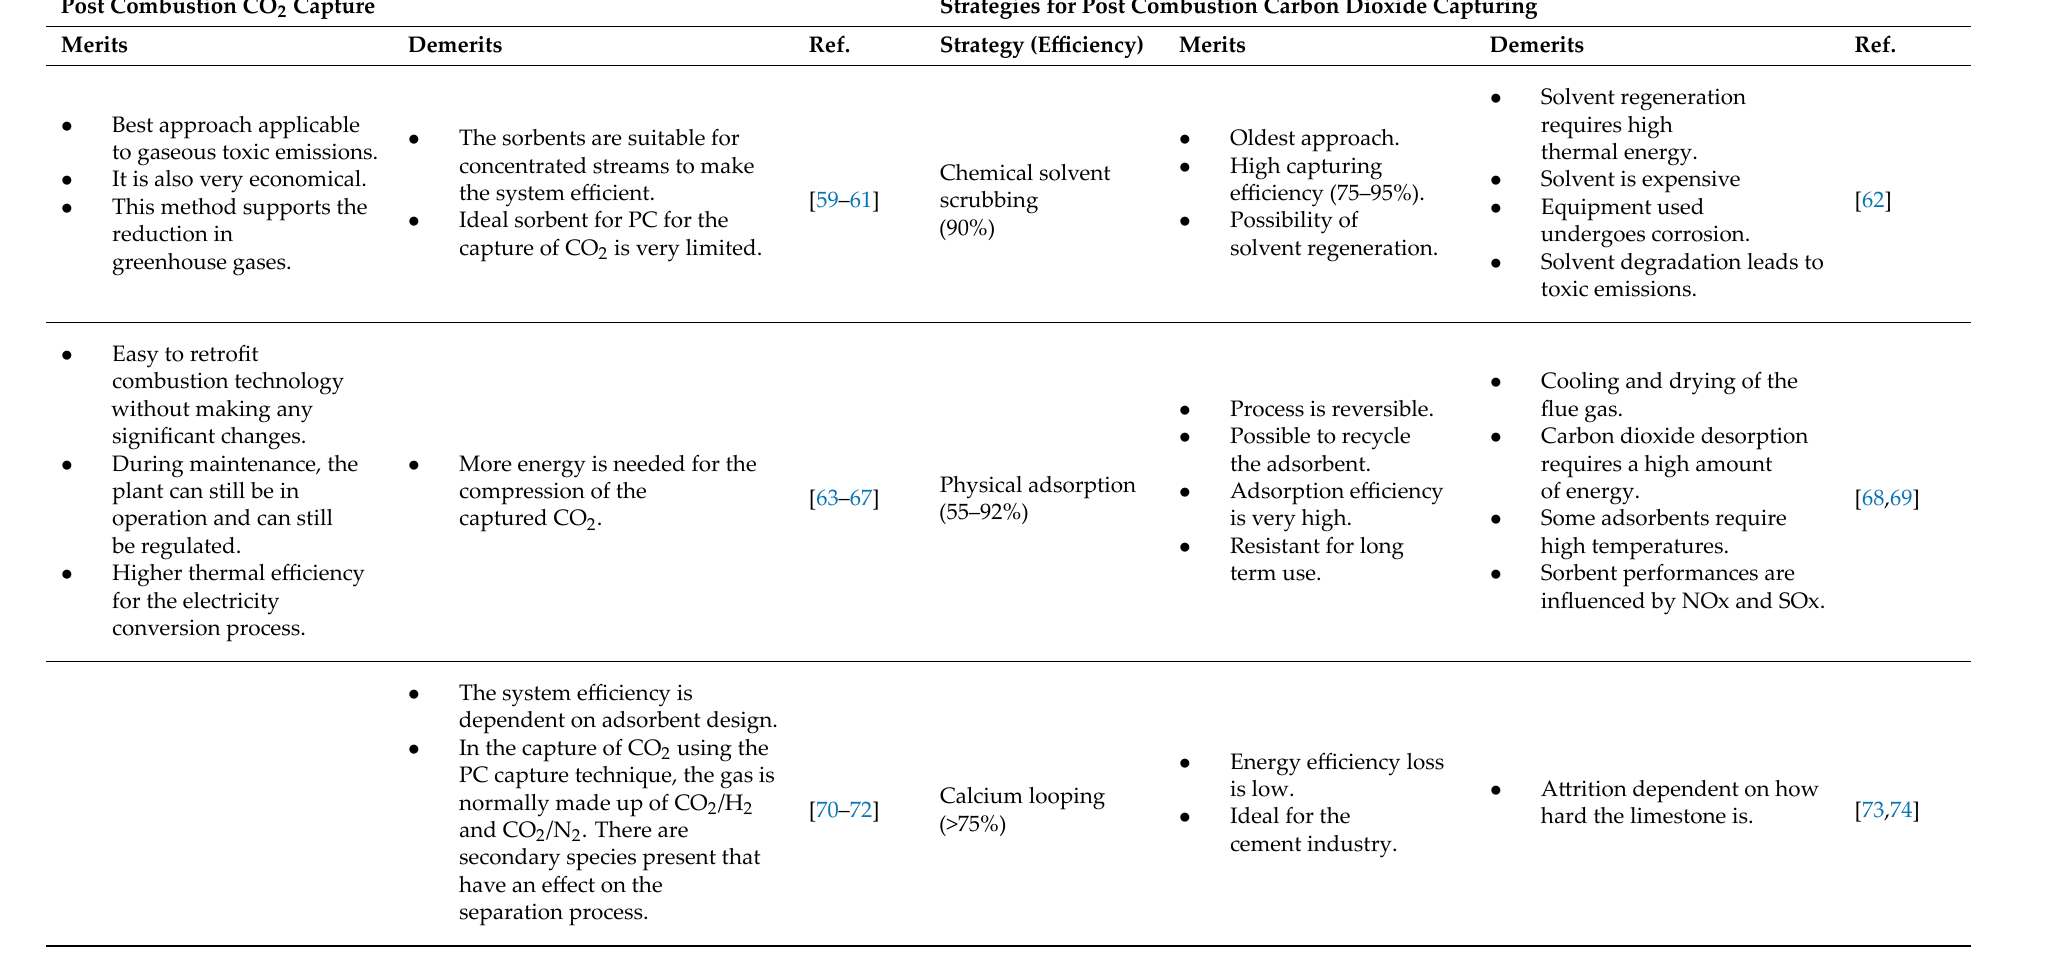
Table 2. Merits and demerits of CO 2 capture via the PC capture approach and its